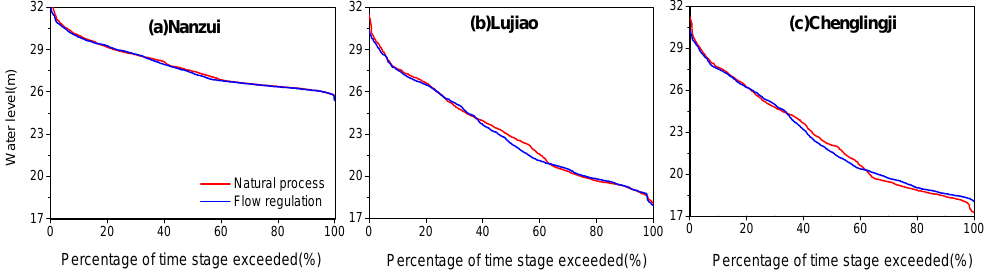
Percentage of time stage exceeded(%)